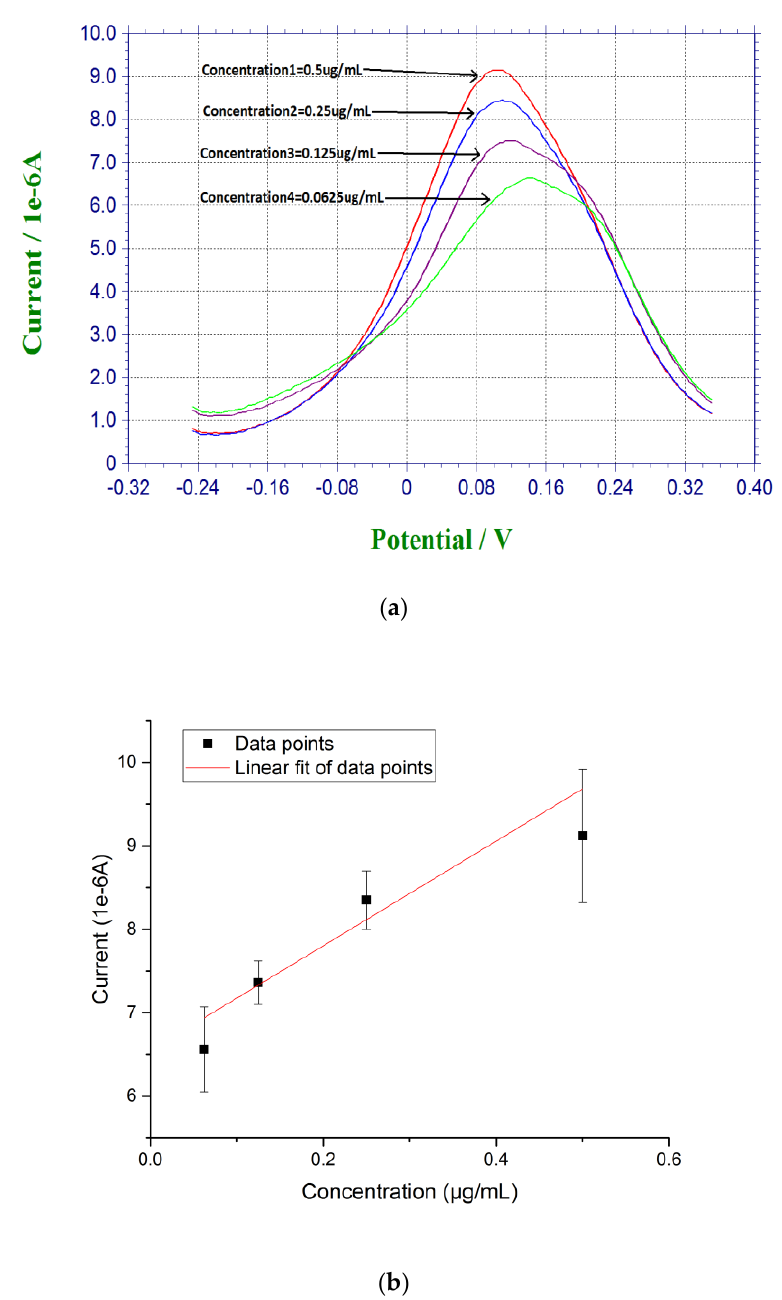
Figure 3. ( a ) DPV measurement of β -amyloid 42 antigens with concentrations ranging from 0.0675 µ g/mL to 0.5 µ g/mL in human serum; and ( b ) Calibration curve based on the DPV measurement of β -amyloid 42 in human serum ( n = 3).